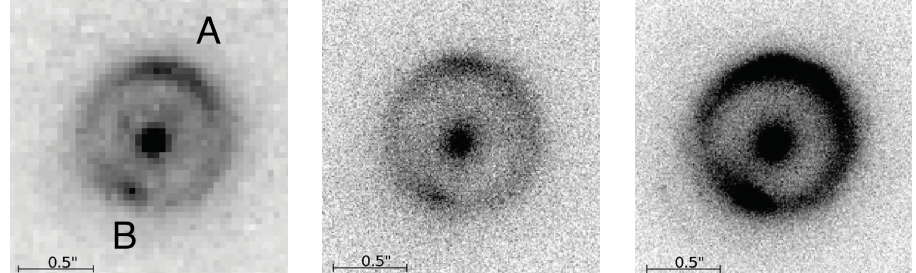
Figure 6. Observational data of B1938+666: F160W band filter of HST NIC1 ( left ); H-band of the Keck NIRC2 camera with Laser Guide Star Adaptive Optics System ( centre ); K’-band of the Keck NIRC2 camera with Laser Guide Star Adaptive Optics System ( right ). North is up and East is to the left. Image credits: part of Figure 1 from [86]